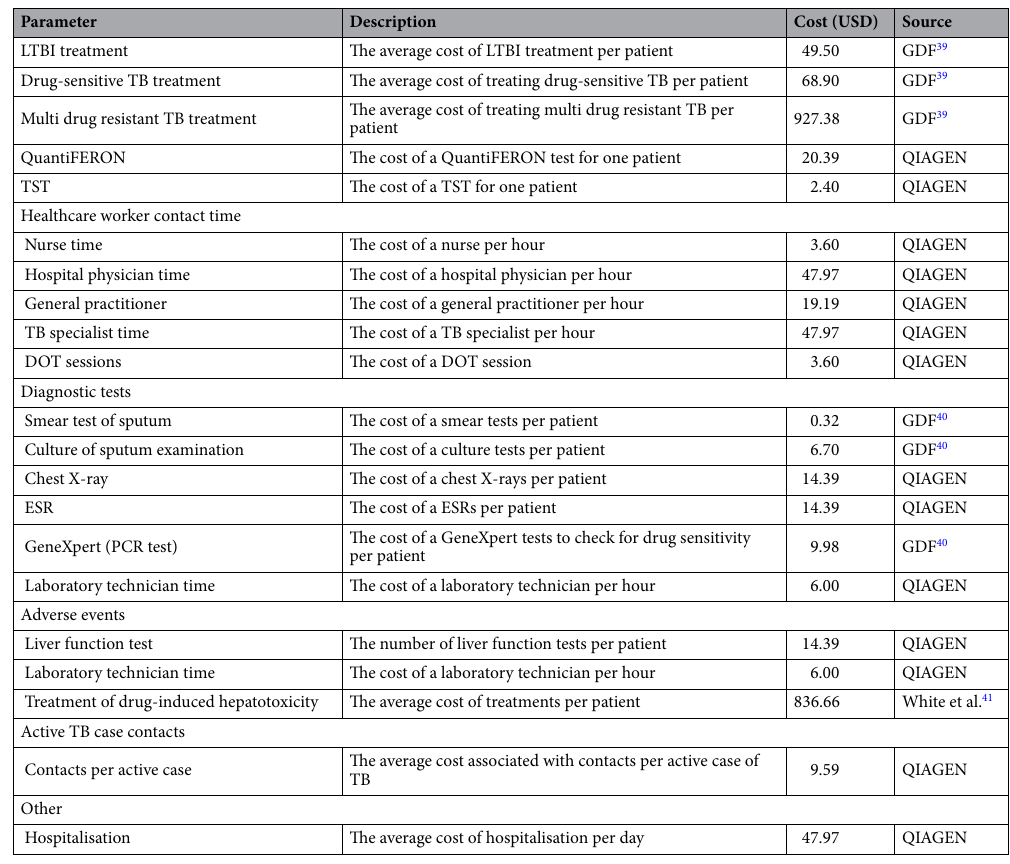
Table 4. Unit costs. AE Adverse event, DOT Directly observed therapy, ESR Erythrocyte sedimentation rate, GDF Global Drug Facility, LTBI Latent tuberculosis infection, PCR Polymerase chain reaction, PSA Probabilistic sensitivity analysis, TB Tuberculosis, TST Tuberculin skin test.